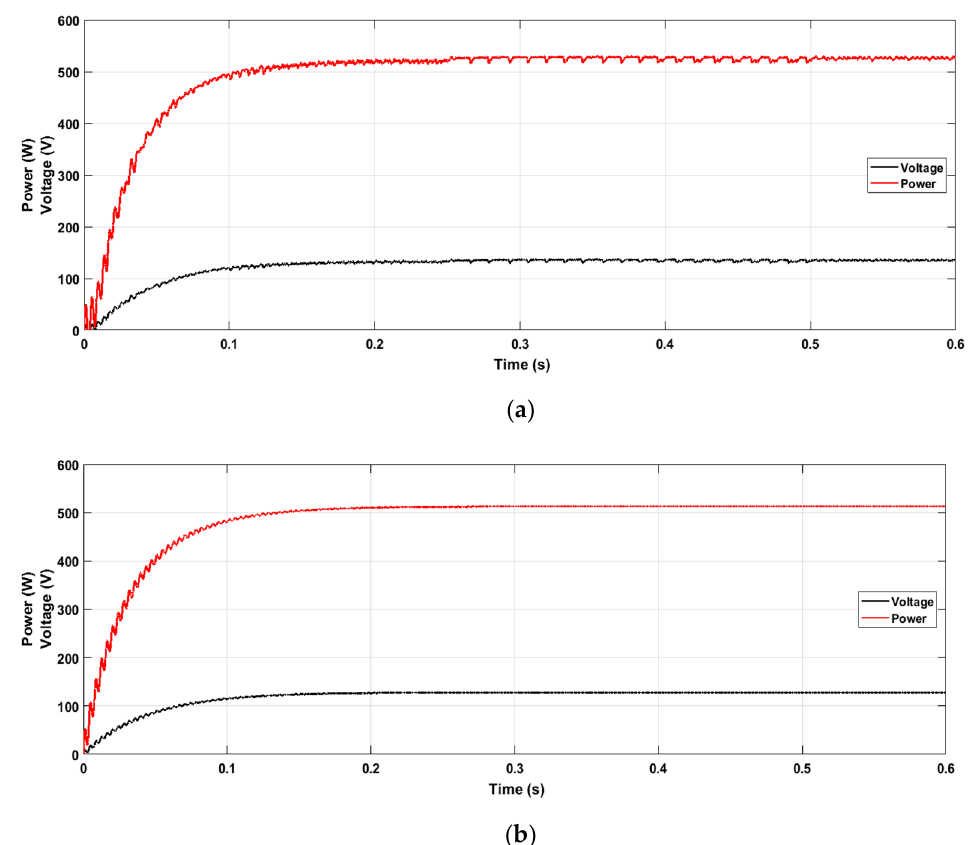
Figure 8. Voltage and power of the TEG with the ( a ) P&O MPPT, and ( b ) IT2FLC MPPT.